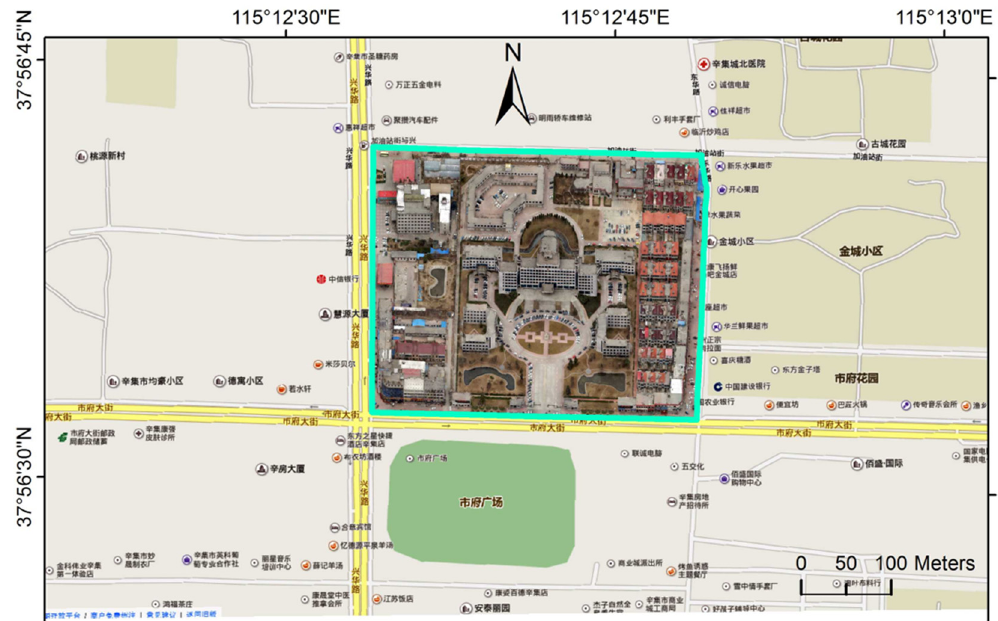
Figure 14. Integrating 2.5D images into a street map for campus navigation.